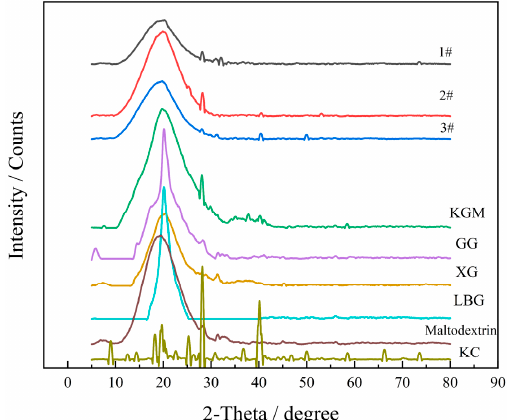
Figure 17. XRD patterns of thickeners and thickening components based on KGM for special medical use.